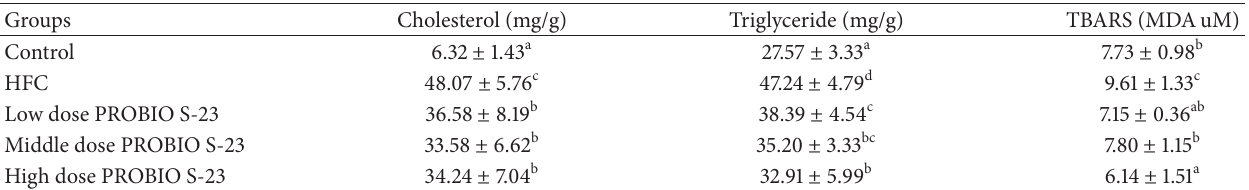
Table 2: Effects of liver lipid profiles of hamsters fed with high fat plus high cholesterol diet after 10 weeks of treatments with different concentrations of PROBIOS-23 Complex